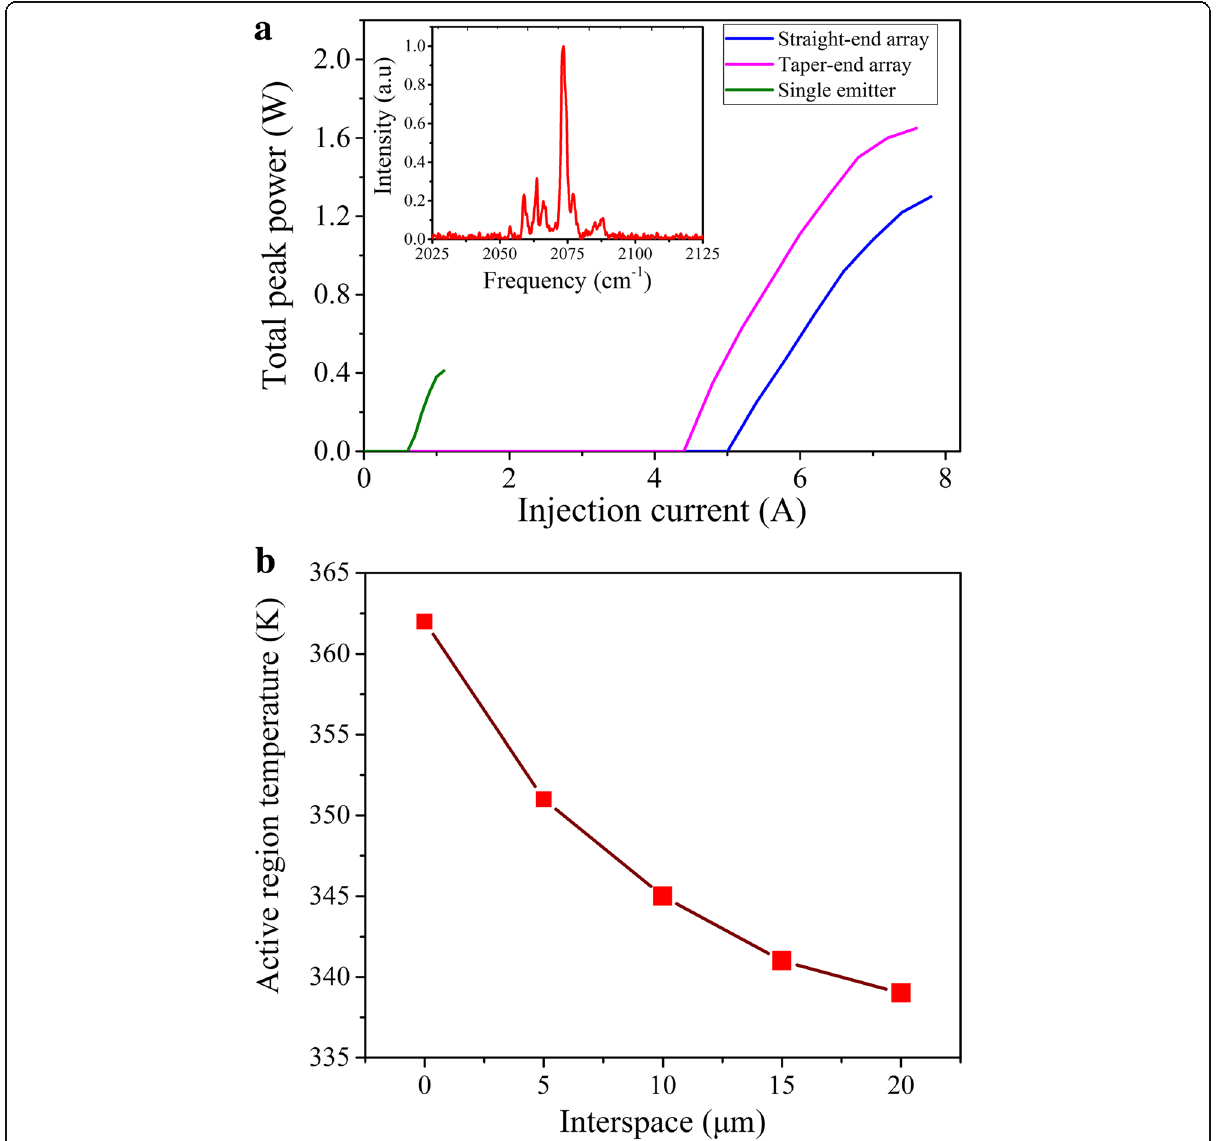
Fig. 5 a Total peak power change as a function of the injection current at 298 K for straight-end (blue line)/taper-end (purple line) connected to the Talbot cavity QCL array and a 2-mm-long × 10- μ m-wide single laser (green line). All of the devices have no coating on both sides of the cavity. The current driver is maintained at 2 kHz with a duty circle of 0.2%. The inset is the lasing spectrum of the straight-end arrays at 1.3 times threshold current, which peaked around 4.8 μ m. b The active region temperature of QCL array changing as a function of array elements interspace. The array elements ridge width is fixed as 10 μ m, and the interspace changes from 0 to 20 μ m with a step of 5 μ